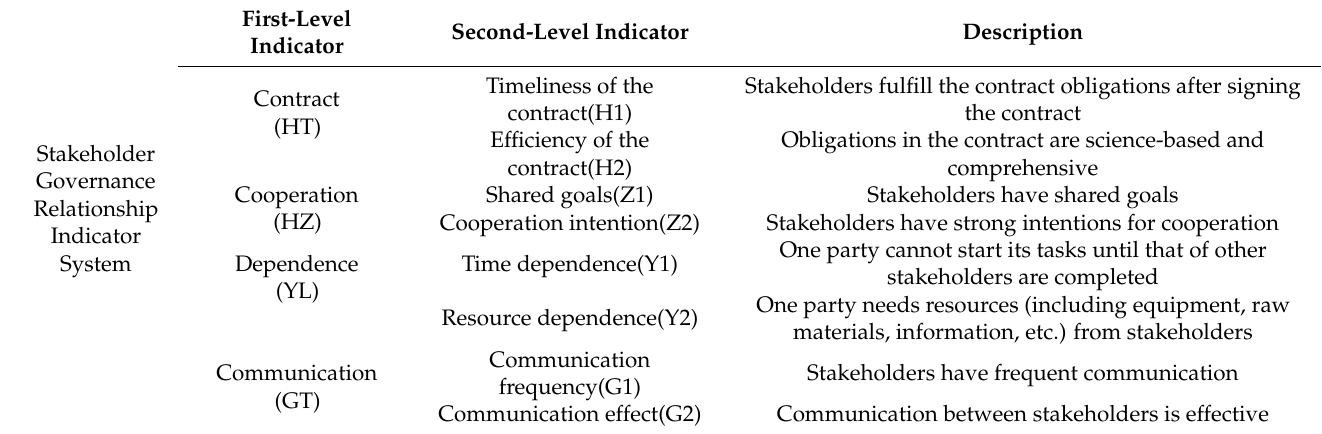
Table A2. Interpretation of Stakeholder Governance Relationship